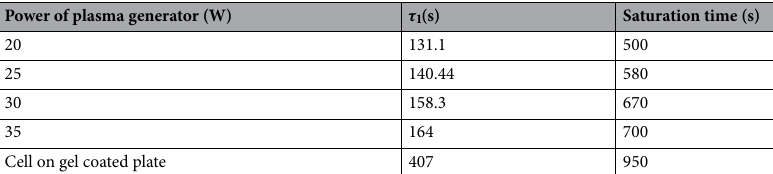
Power of plasma generator (W) τ 1 (s) Saturation time (s)